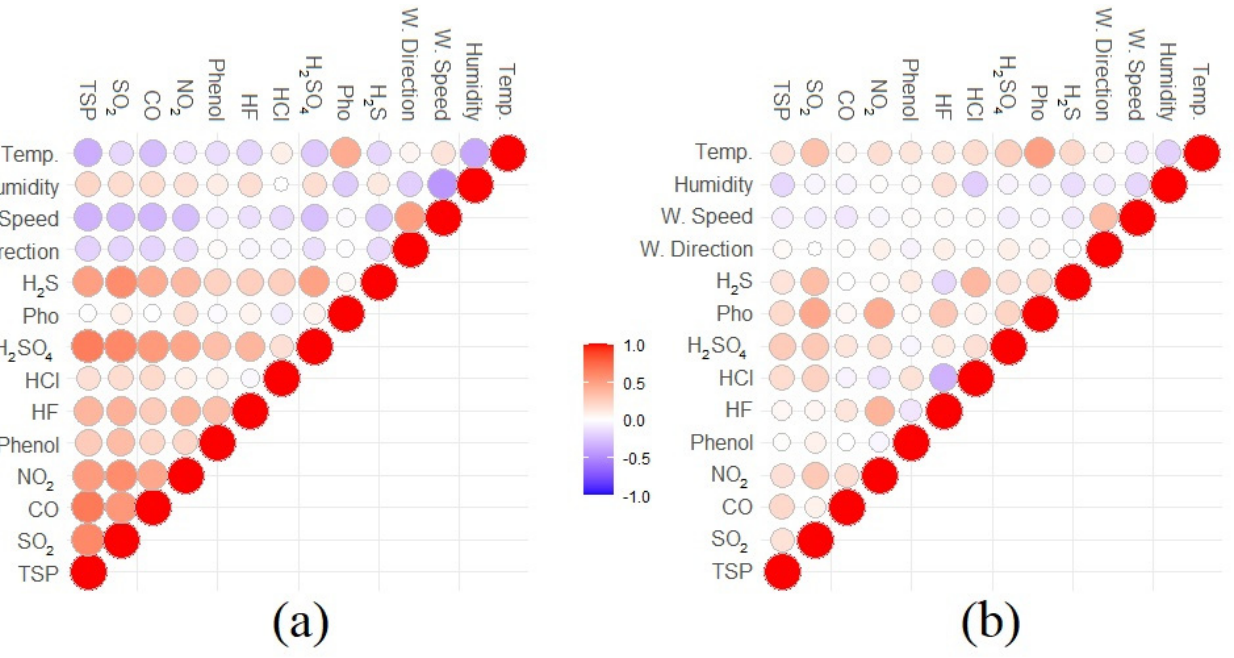
Figure 6. Pearson correlation matrix air quality parameters and climate characteristics for ( a ) the cold and ( b ) the warm seasons. Table 4. Principal Component Analysis for the cold seasons.